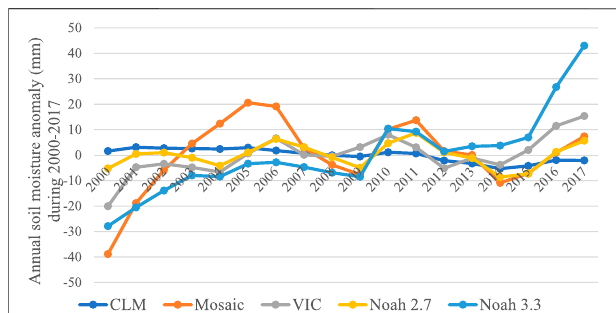
FIGURE 2 | Anomaly of annual soil moisture of the fi ve different models: CLM, Mosaic, VIC, Noah 2.7 and Noah 3.3 over Xinjiang during the period of 2000 – 2017.